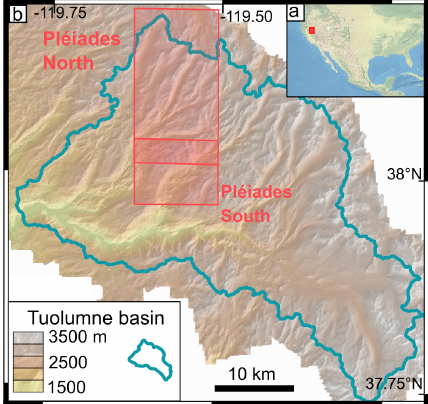
Figure 1. The Tuolumne basin is located in California, USA (a) . Pléiades image footprint (red polygon) in the Tuolumne basin (blue line) (b) . The terrain elevation in the background is the snow-off digital elevation terrain from ASO used in the coregistration step.